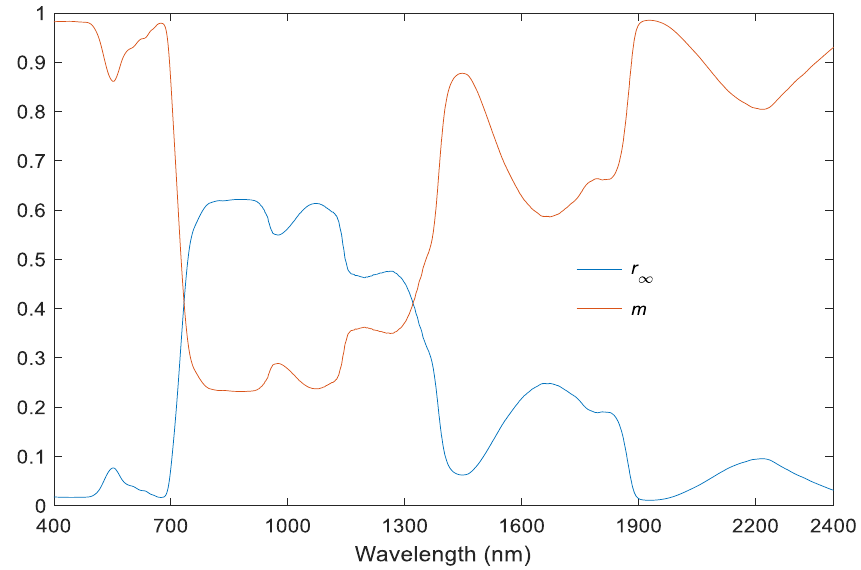
Figure 1. Spectra of the infinite canopy bi-hemispherical reflectance and the diffusion exponent m for a spherical leaf angle distribution as obtained from the Fluspect-B model with the inputs of Table 2.